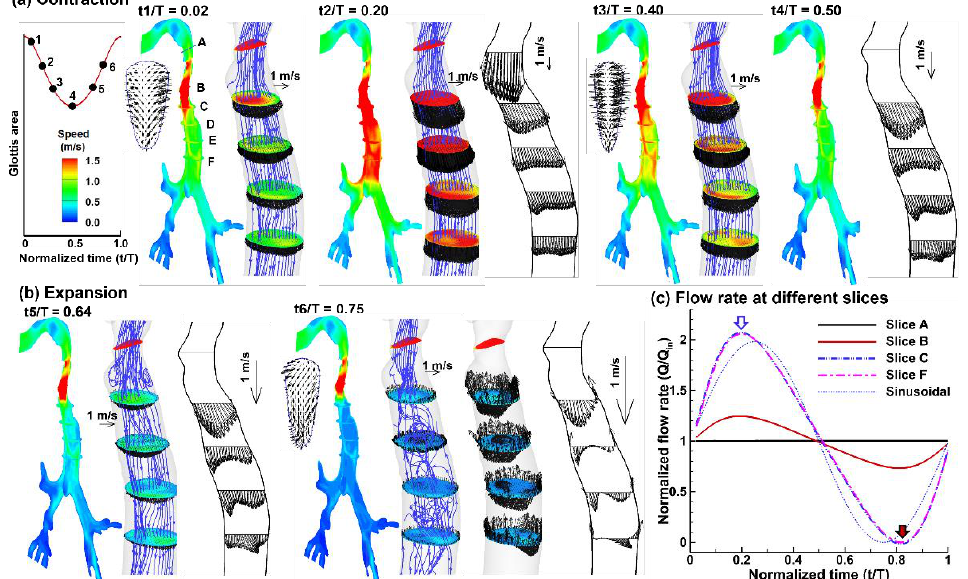
Figure 3. Flow evolution during a glottal vibration cycle at f 0 = 200 Hz: ( a ) contraction, ( b ) expansion, and ( c ) time evolution of the flow rate at different slices in comparison to the sinusoidal waveform. There was a phase advance of the flow during expansion and a phase lag during contraction relative to the glottal sinusoidal waveform.